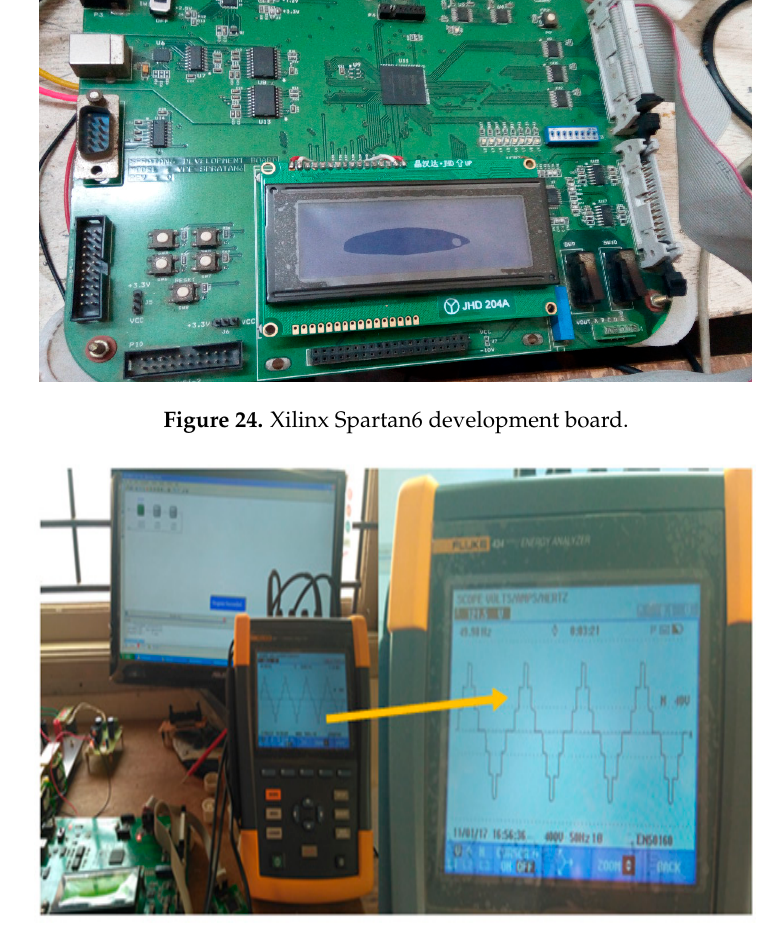
Figure 25. Seven-level stepped output voltage of TLBC-fed DCLCHB inverter system.